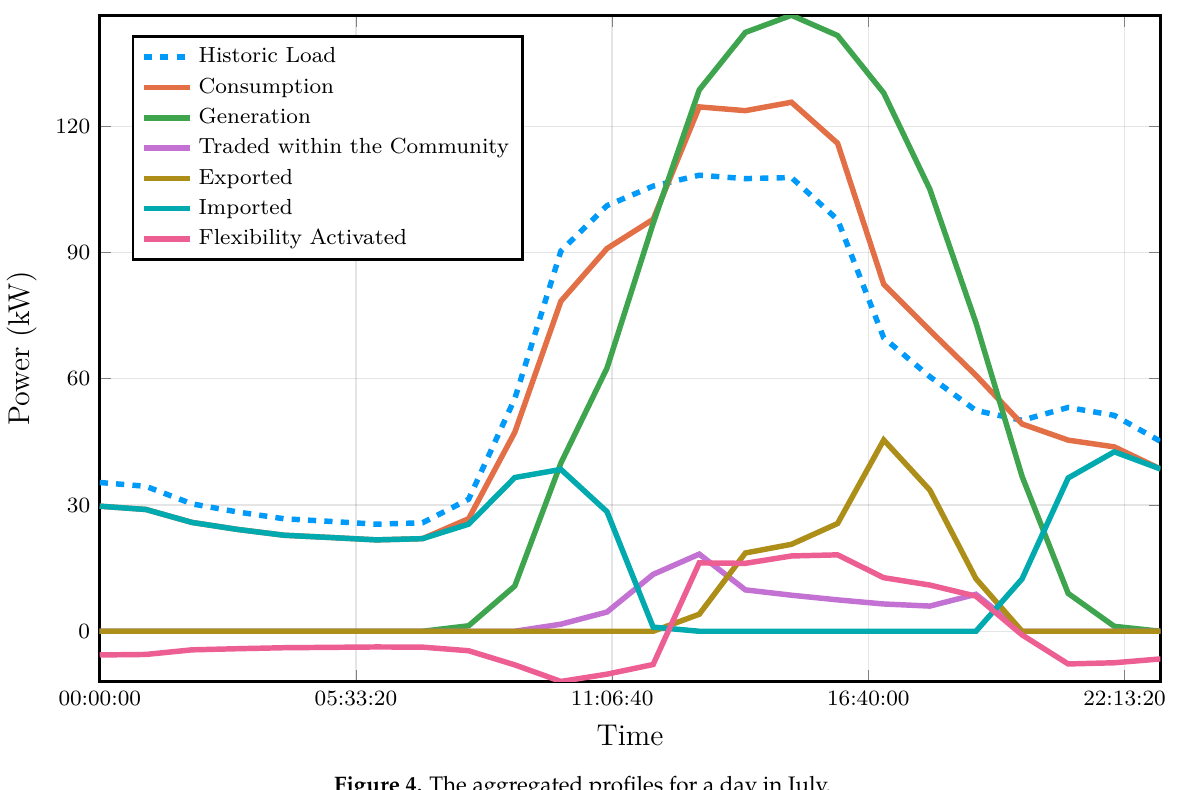
Figure 4. The aggregated profiles for a day in July.